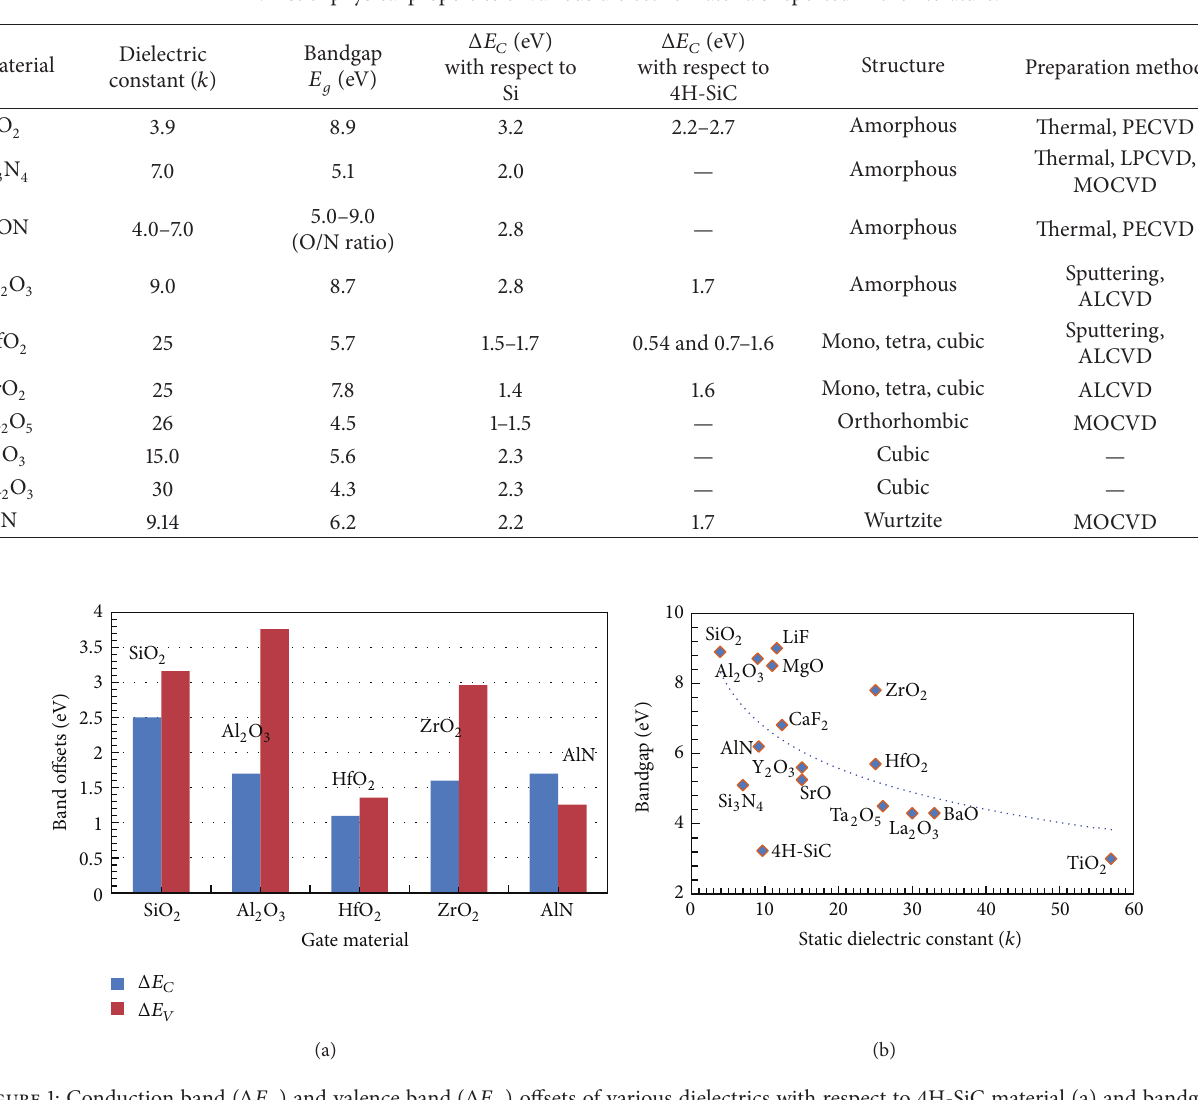
MOSFETs. Influence of dielectric constants, dielectric thick- nesses, and interface state densities has been studied using two-dimensional numerical computer